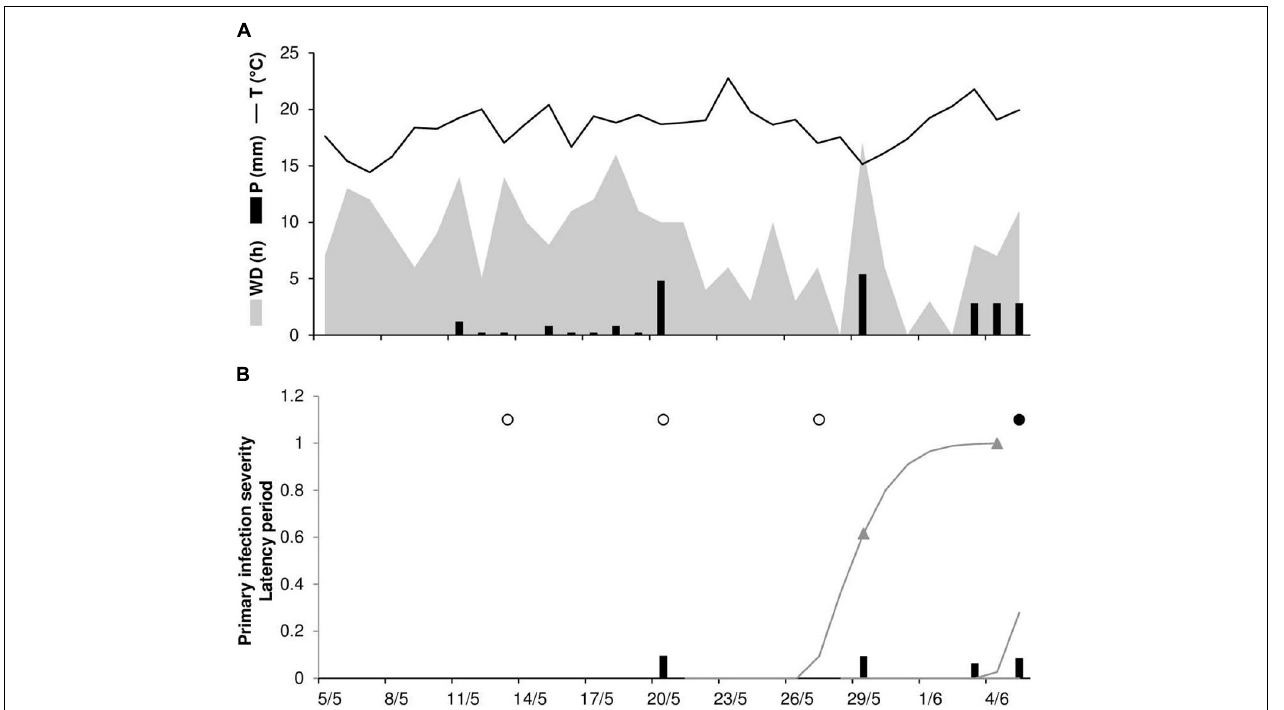
FIGURE 2 | Predicted and observed primary infection onset in the experimental wheat field in Ravenna, Italy, in 2020 (RAV20). (A) Weather variables: air temperature (T, ◦ C, solid line), rainfall (R, mm, black bars), and wetness duration (WD, in h, gray area). (B) Predicted primary infection (black bars); progress of latency (gray line); period of uredia eruption, from 50 to 100% of erupted uredia (line between triangles); days on which stem rust symptoms were not observed (empty dots); days on which uredia were observed in field plots (full dots).